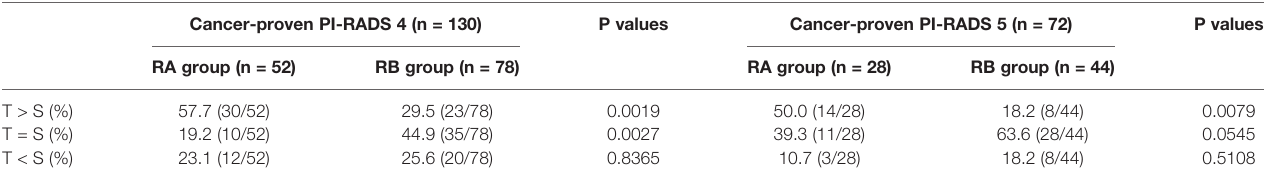
TABLE 2 | Comparison of Gleason scores from target and systematic